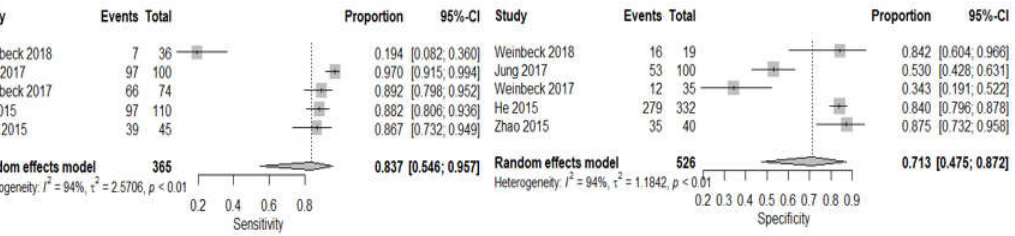
Figure 8. Forest plots using random effects univariate meta-analysis model for CBBCT showing pooled sensitivity and pooled specificity.